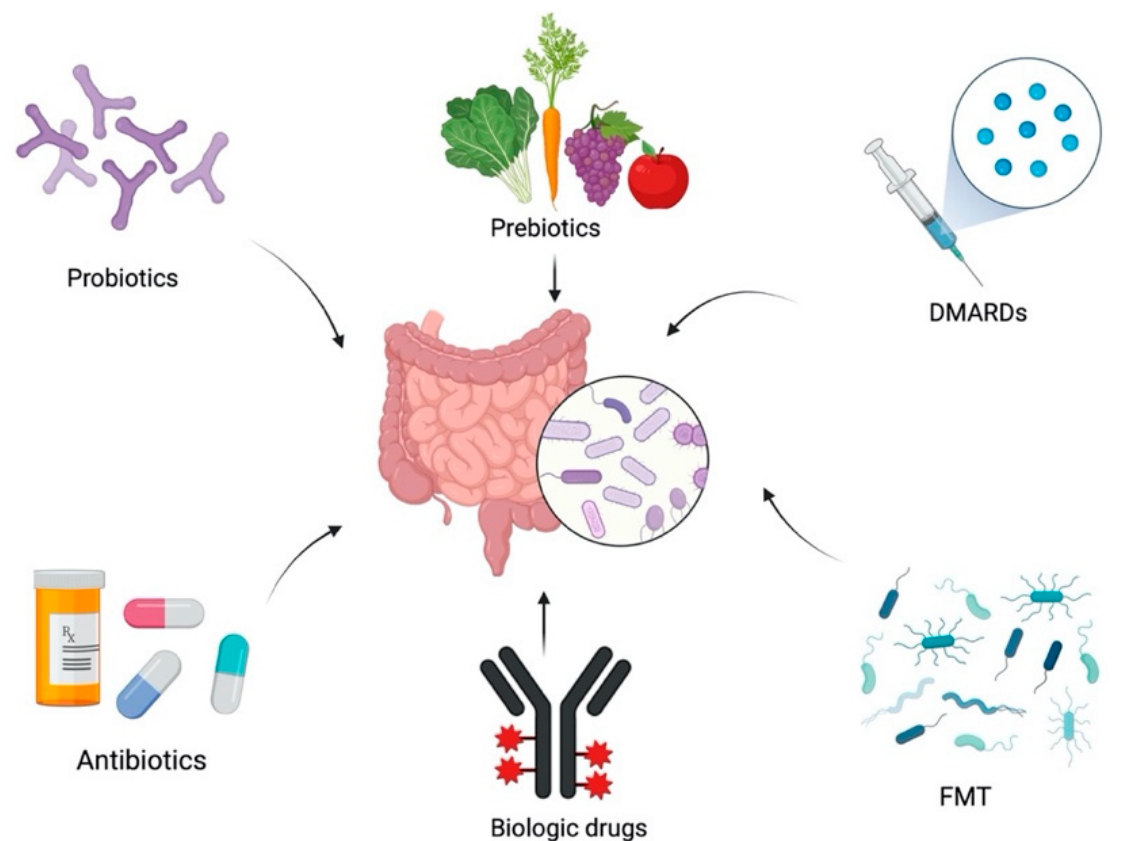
Figure 2. Therapeutic approaches that modify the intestinal microbiota. Created with BioRen ‐ der.com. FMT: Faecal microbiota transplantation. DMARDs: Disease ‐ modifying anti ‐ rheu ‐ matic drugs.